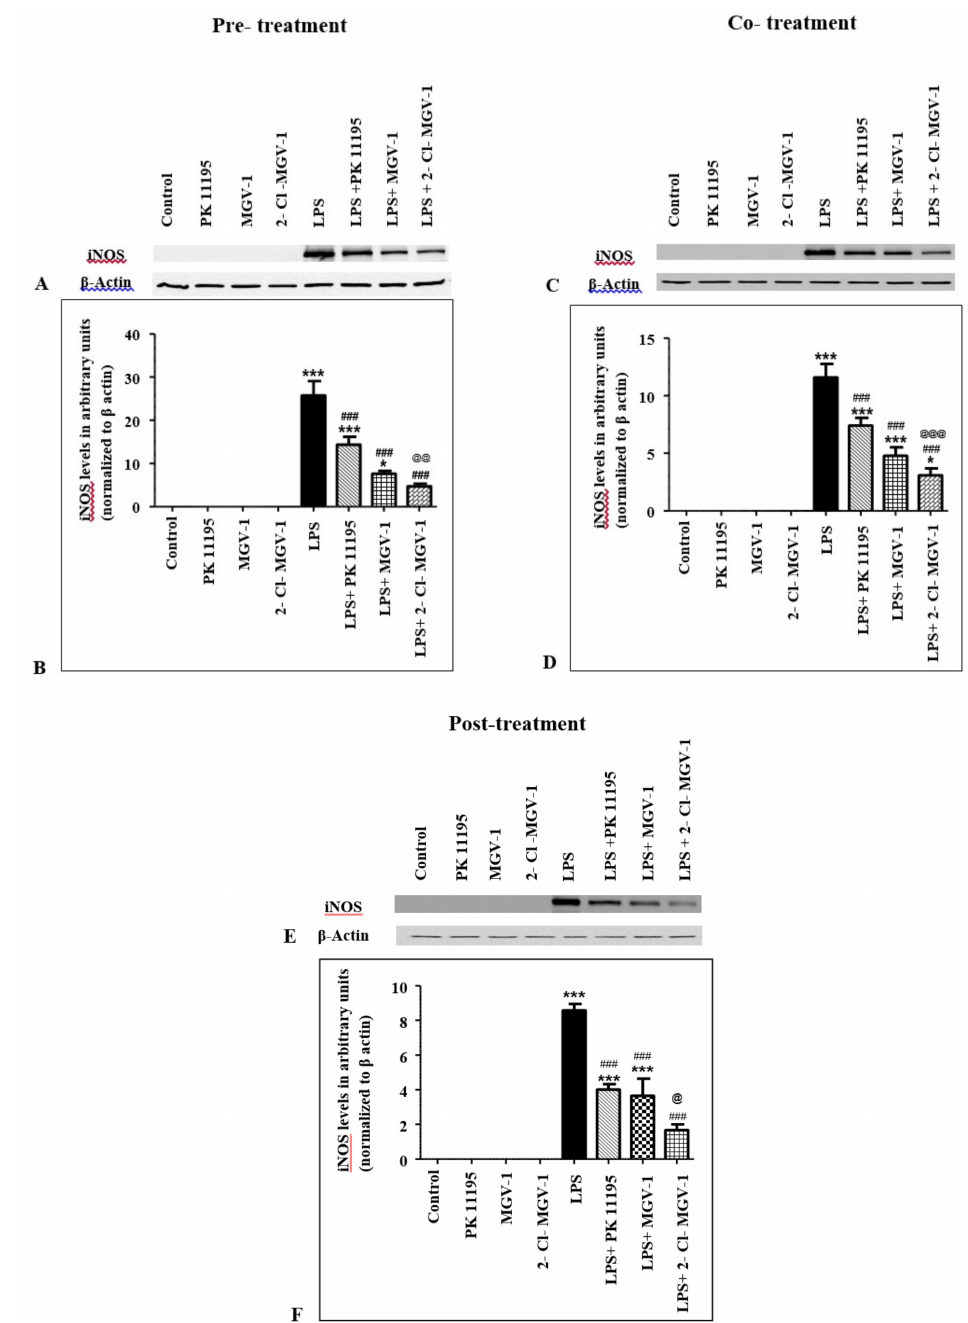
Figure 2. TSPO ligands reduced iNOS expression levels in LPS-treated BV-2 cells. BV-2 cells were treated with 100 ng/mL LPS for 24 h, with or without TSPO ligands (25 µ M) in three different scenarios. A , C,E : Representative Western blots of iNOS and β -actin expression levels in pre-treatment, co-treatment, and post-treatment, respectively, with the three TSPO ligands. B,D,F : Relative iNOS protein expression levels normalized to β -actin in pre-treatment, co-treatment, and post-treatment, respectively, with TSPO ligands. Results were calculated using densitometry and presented as means ± SEM; n = 4 (pre-treatment), n = 5 (co-treatment), n = 3 (post-treatment). * p < 0.05, *** p < 0.001 compared to Control; ### p < 0.001 compared to LPS; @ p < 0.05, @@ p < 0.01, @@@ p < 0.001 compared to LPS + PK